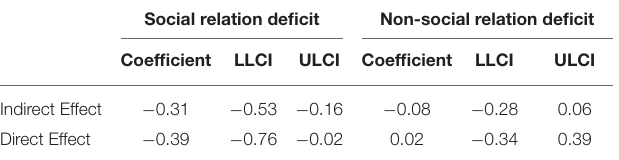
TABLE 1 | Results of Experiment 2: indirect-direct effect of defensive reaction tendencies between the locus of control and willingness to purchase self-improvement products under social deficit and non-social deficit